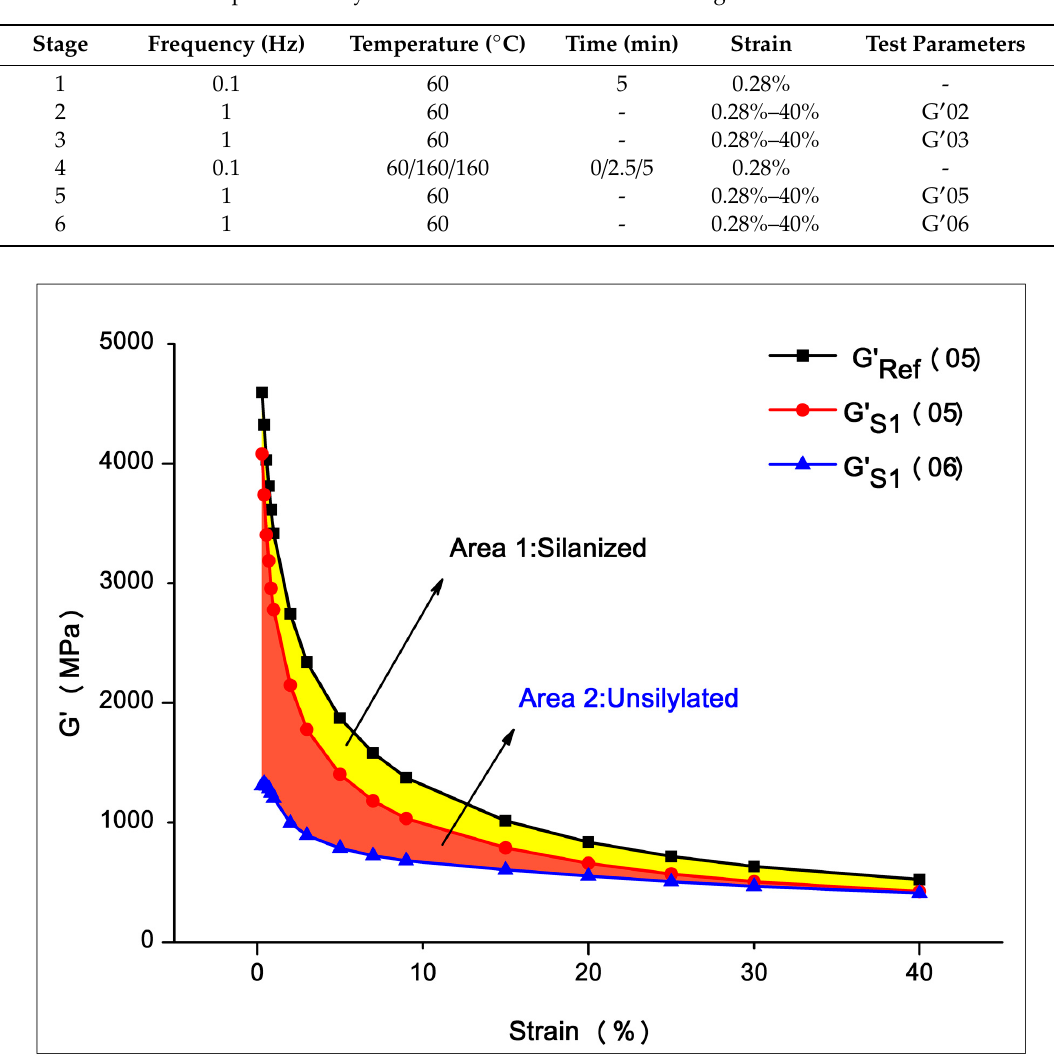
Table 4. Rubber process analyzer method used to measure the degree of silanization reaction.